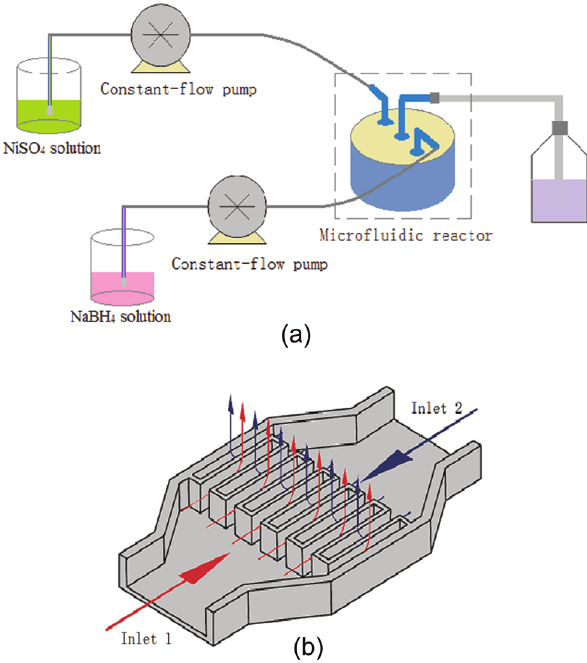
Figure 1: Schematic of the synthesis processes of Ni-B amorphous nanoparticles (a) and microfluidic reactor mixing principle